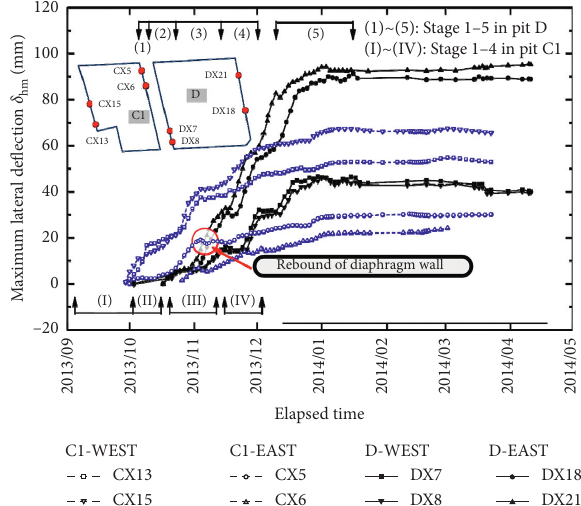
Figure 9: Measured maximum lateral deflections of adjacent foundation in both pits C1 and D.